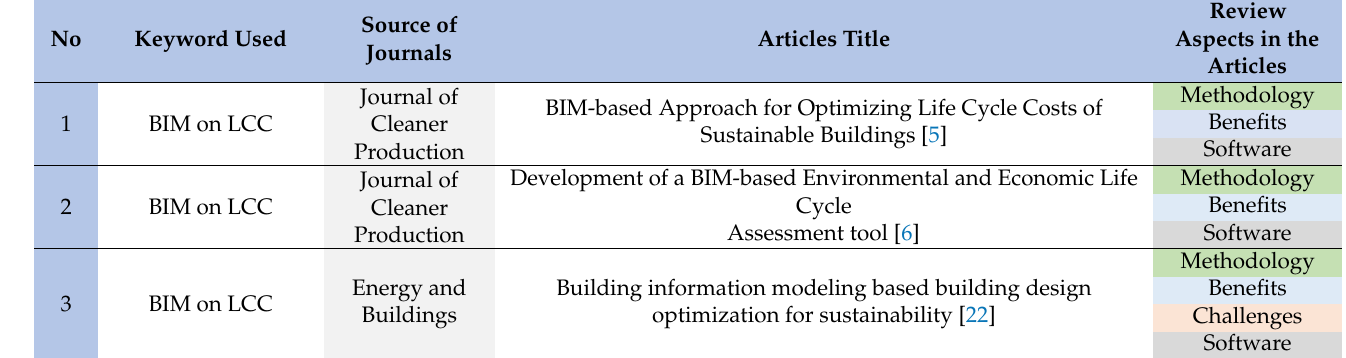
Table 2. The selected articles with regard to the review